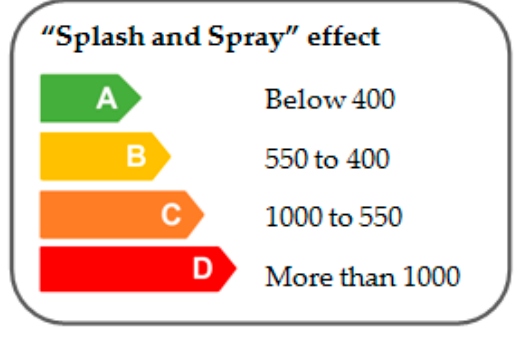
Figure 21. Macrotexture and skid resistance global label.